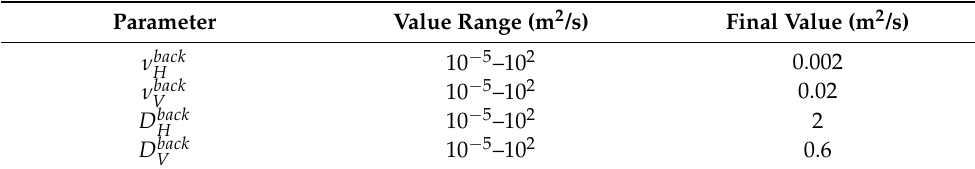
Table 5. Background calibration parameters for simulations.